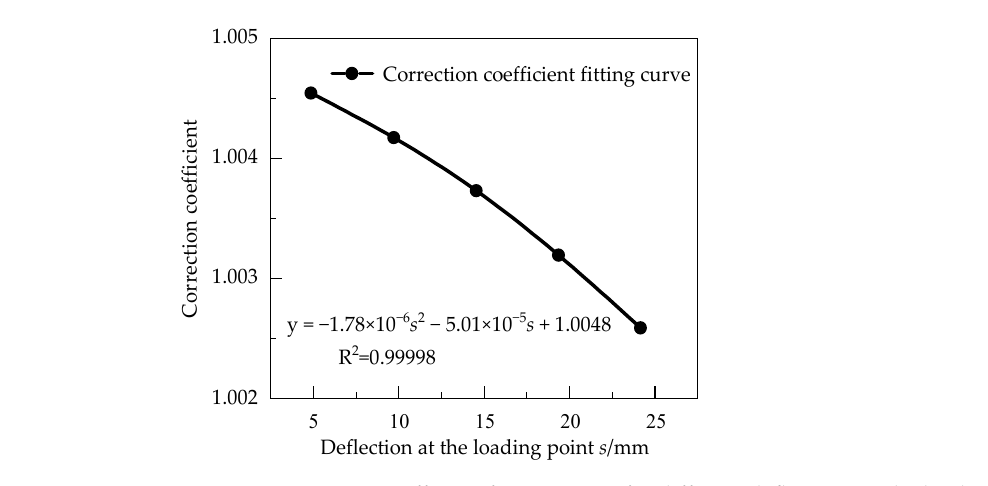
Figure 4. Correction coefficient fitting curves for different deflections at the loading point.